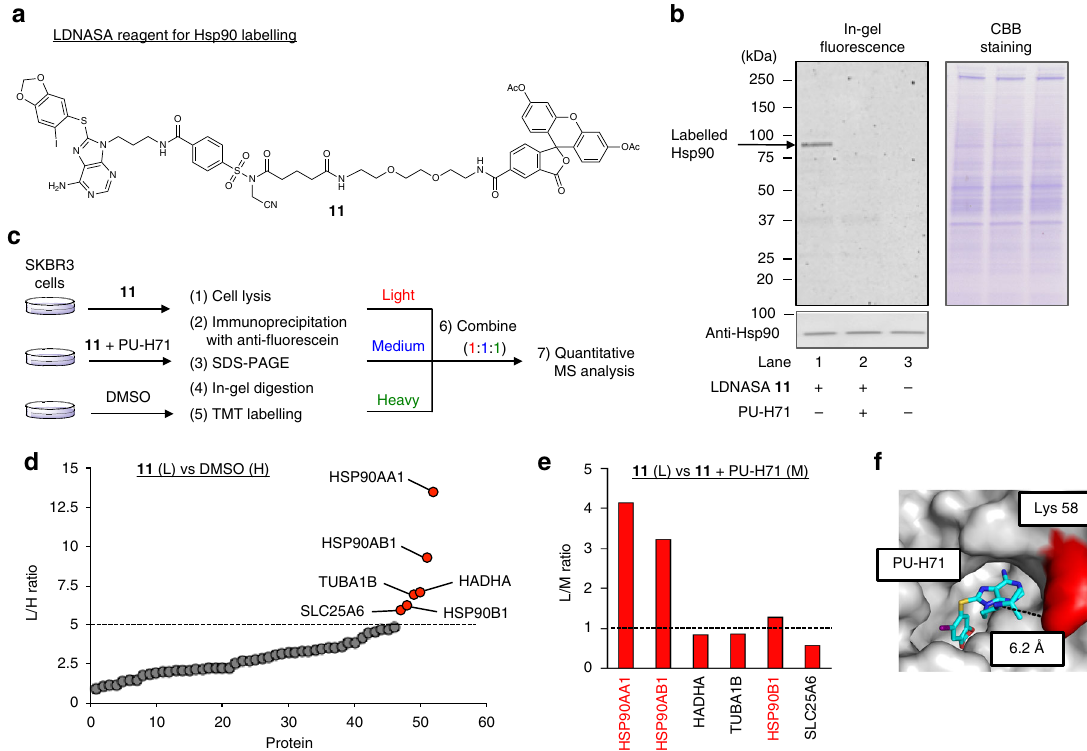
Fig. 5 Selective and site-speci fi c labelling of endogenous Hsp90 in live cells. a Molecular structure of LDNASA 11 for Hsp90 labelling. b SDS-PAGE and western blotting analysis of the labelling reaction in live SKBR3 cells. The cells were treated with 11 (0.5 µ M) in the absence or presence of PU-H71 (10 µ M) for 3 h at 37 °C in medium (pH 7.4). After washing, the cells were lysed and analysed by in-gel fl uorescence and western blotting using anti-Hsp90 antibody. c Work fl ow for TMT-based quantitative LC-MSMS analysis of proteins labelled with 11 . After in-gel digestion, obtained peptide fragments were modi fi ed with Light- (L-), Medium- (M-), or Heavy- (H-) TMT reagent for samples treated with 11 (0.5 µ M, 3 h), 11 with PU-H71 (10 µ M), or DMSO, respectively. d L/H ratio plots for total proteins identi fi ed in experiments comparing cells treated with 11 versus DMSO. Proteins with median L/H ratios >5 are assigned as 11 -labelled proteins (red plots). e L/M ratios ( 11 versus 11 with PU-H71) of proteins assigned as 11 -targets. Gene names of ligand-speci fi c targets (L/M ratios >1) and off-targets (L/M ratios <1) are written in red and black, respectively. f The crystal structure of the N -terminal ATP binding domain of Hsp90 α – PU-H71 complex (PDB ID: 2FWZ). The residue (Lys 58) modi fi ed with 11 and 12 is highlighted in red, and the PU-H71 ligand is